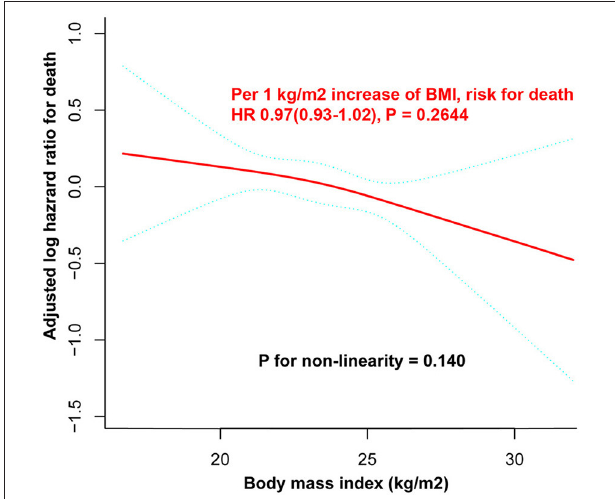
FIGURE 4 | Dose-response curve between BMI and all-cause mortality. There was a linear relationship between BMI and all-cause mortality ( P for non-linearity = 0.140). The adjusted log HR and its 95% CI are represented by the solid blue and dashed blue lines, respectively. All the covariates listed in Table 1 were used as adjustment factors. No statistically significant association between BMI and all-cause mortality was observed (for every